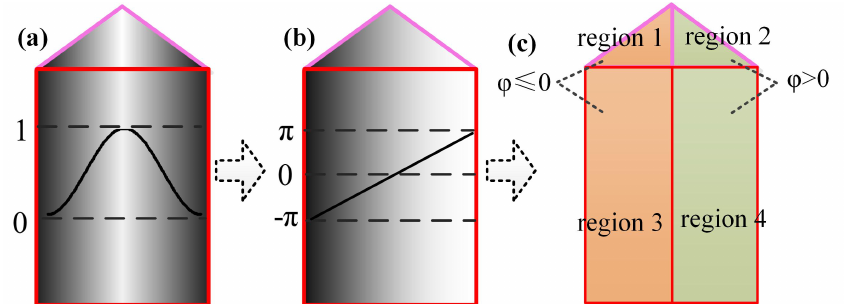
Figure 6. Recognition of semiperiodic connected regions of EWP: ( a ) sinusoidal fringe; ( b ) EWP; ( c ) semiperiodic wrapped phase connected regions, ϕ is the wrapped phase.